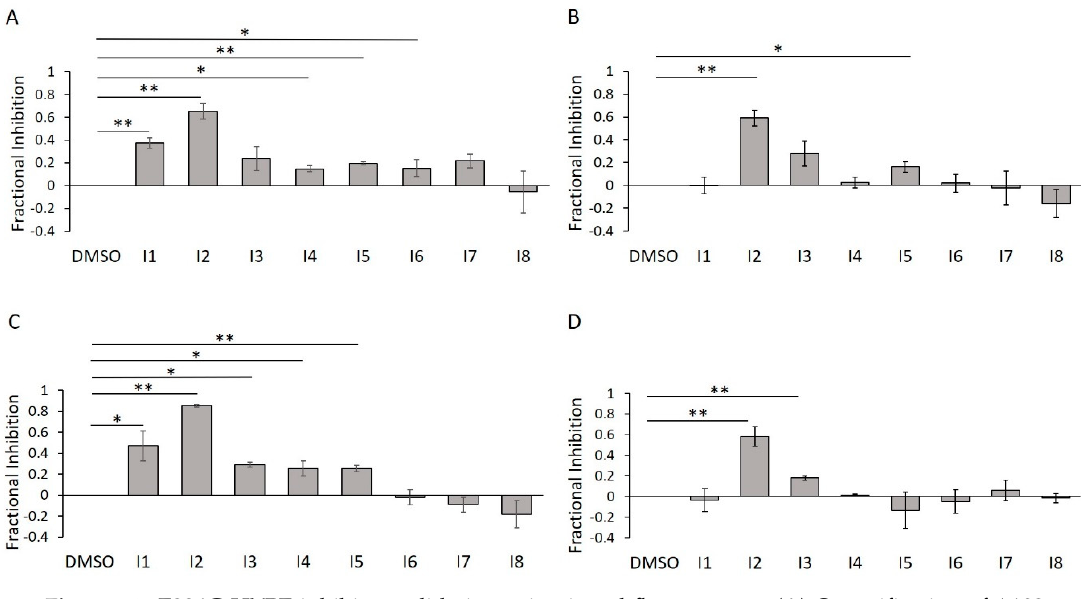
Figure 14. E234G HYPE inhibitor validation using in-gel fluorescence. ( A ) Quantification of ∆ 102 E234G HYPE in-gel fluorescence autoAMPylation reaction in minimal bu ff er without detergent. ( B ) As in ( A ), but with 0.1% Triton X-100. ( C ) As in ( A ), but with ∆ 45 E234G HYPE. ( D ) As in ( A ), but with ∆ 45 E234G HYPE and 0.1% Triton X-100. Quantified data represented as the mean +/ − SEM of three independent experiments. Unpaired t -tests were performed: * = p < 0.05; ** = p < 0.01.